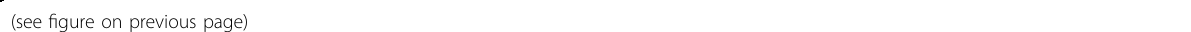
Fig. 1 Characterization of the senescence-associated secretome (SAS) of BTG3-depleted IMR-90 cells. a Scheme for preparation of conditioned medium. b Analysis of MMP ELISA array with conditioned media from IMR90 cells transfected with control (sc) or BTG3 siRNA. Averages of two independent experiments are shown. c Analysis of the cytokine ELISA array with the same conditioned medium as used in ( b ). Mean ± SD from 3 independent experiments is shown. A complete set of data can be viewed in Fig. S1. d Conditioned medium (CM) from BTG3 knockdown IMR-90 promotes HUVEC tube formation. HUVEC cells were resuspended in CM and plated on Matrigel. After 16 h, cells were stained with Calcein AM, and the images were analyzed by MetaXpress High Content Image Acquisition & Analysis Software and the quanti fi ed results were shown on the left. were incubated with CM from control or BTG3 knockdown IMR90 cells for 48 h before scattering was measured ( e ). T47D cell lysates were also collected for western blot analysis using the antibodies indicated ( f